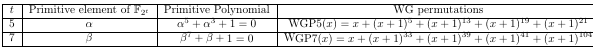
Table 7. The summary of simulation results over F